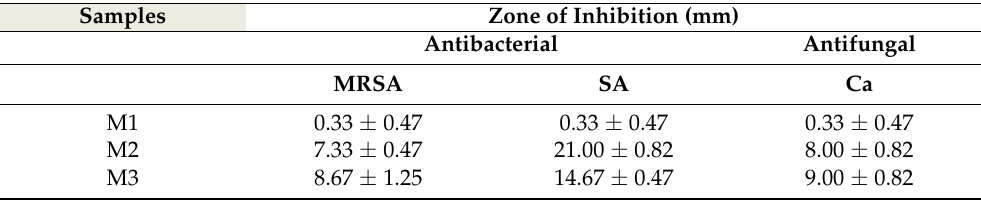
Table 3. Antibacterial and antifungal activities of chitosan, AgNPs, and AgCS.